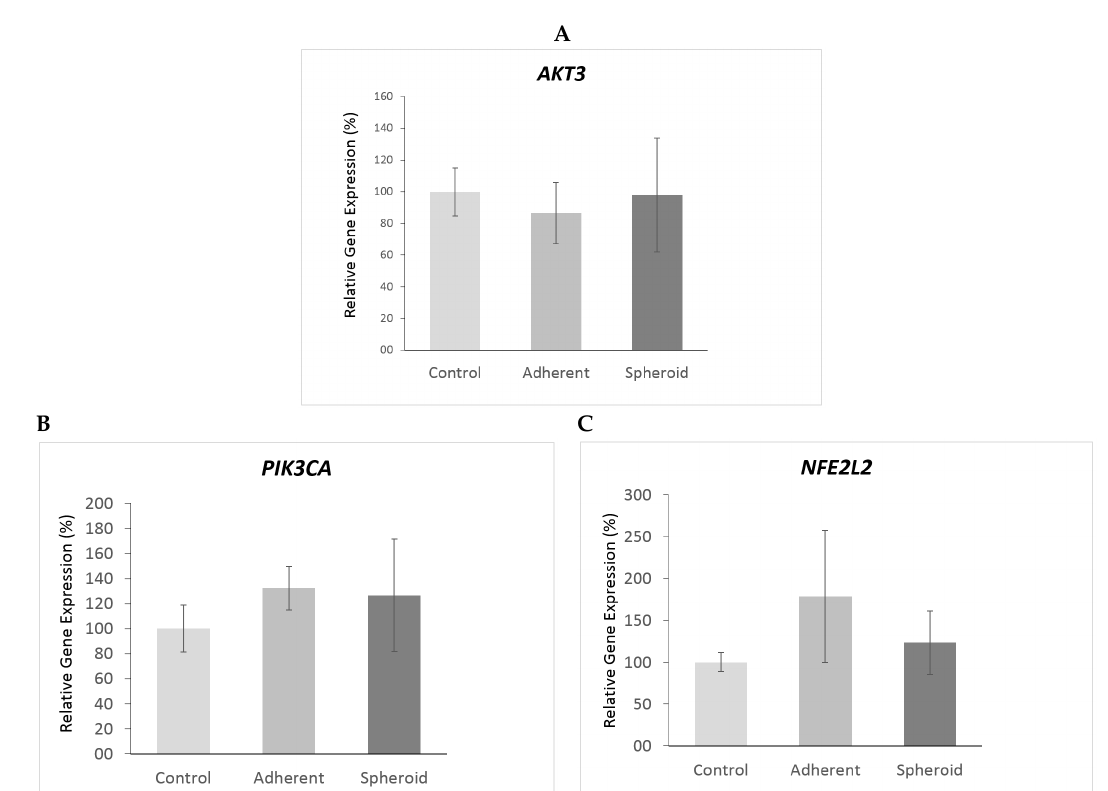
Figure 10. No significant changes in gene expression for AKT3 ( A ), PIK3CA ( B ), or NFE2L2 ( C ) could be observed for the adherent cells under simulated microgravity or for the spheroids. No western blot confirmation was done for the corresponding gene products.